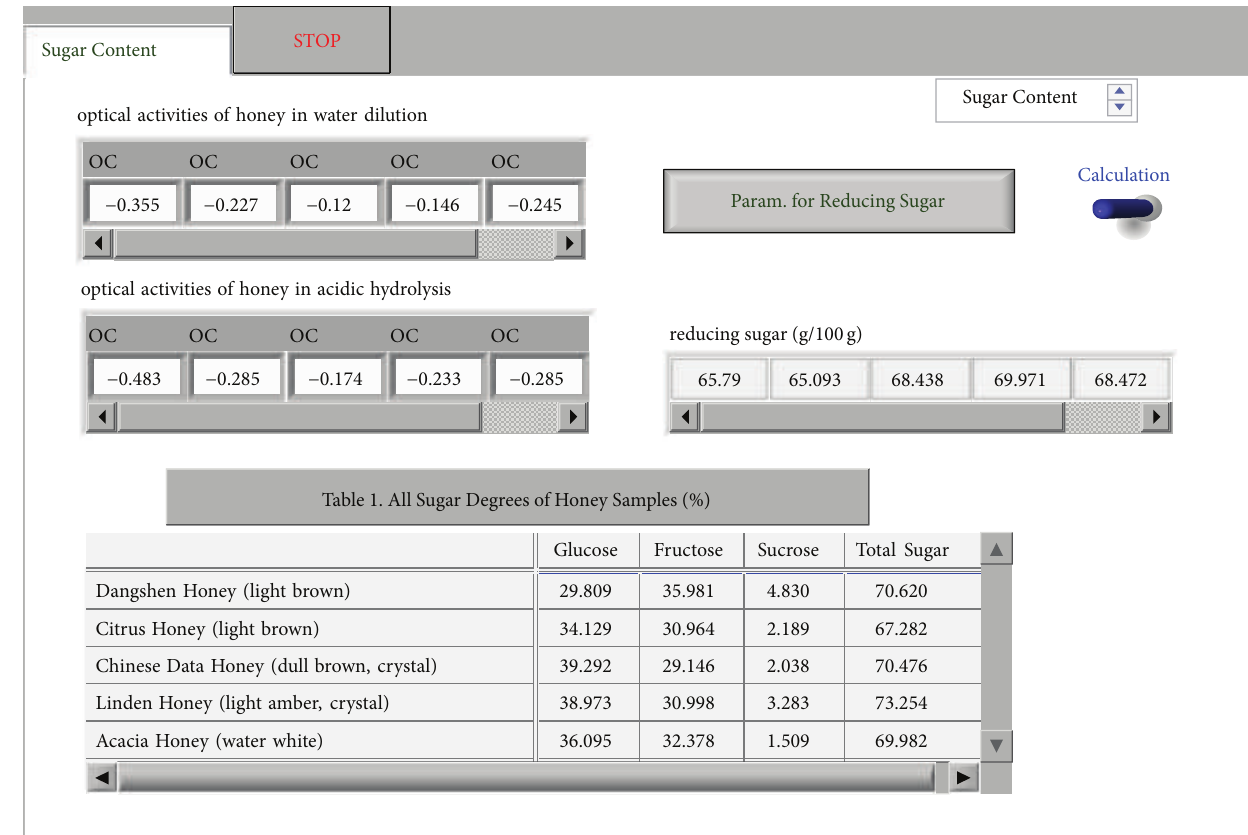
Table 1. All Sugar Degrees of Honey Samples (%)